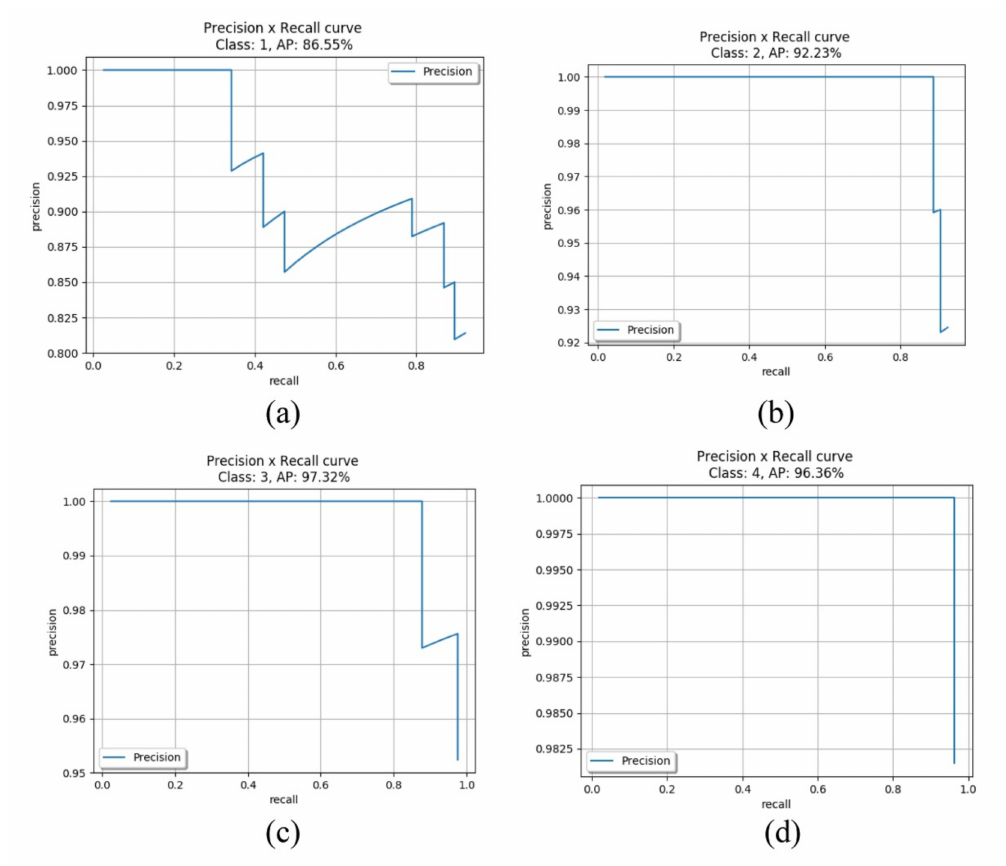
Figure 11. Precision / recall curves of various electronic components. ( a ) Electrolytic capacitor. ( b ) Resistance. ( c ) Tantalum Capacitor. ( d )